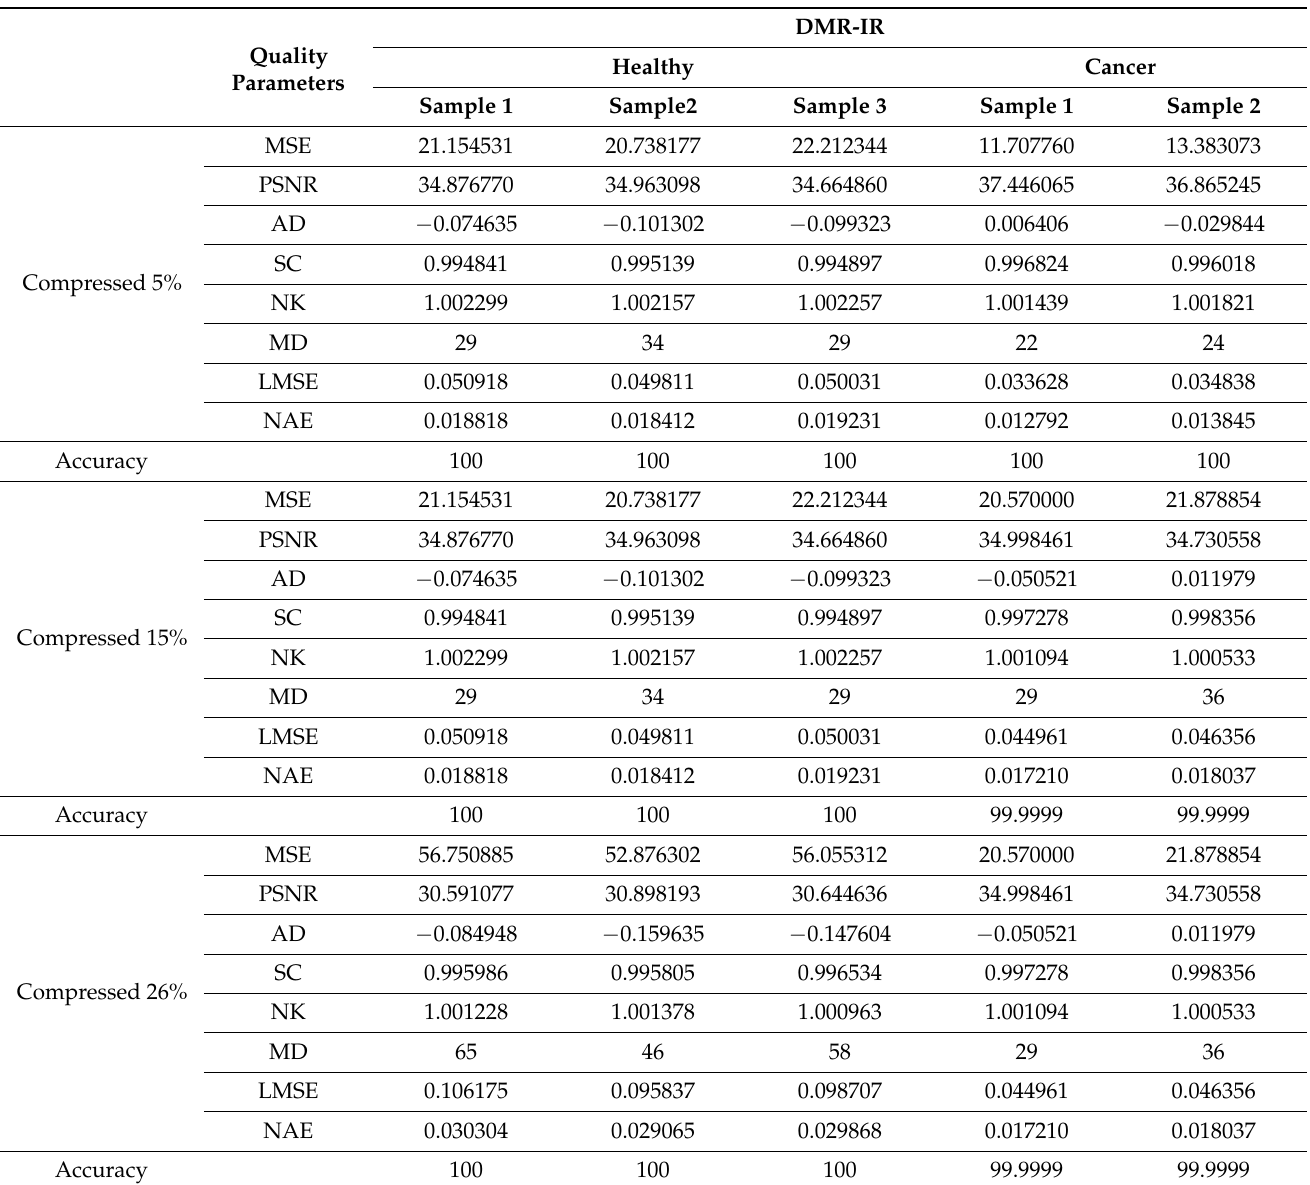
Table 4. Compressed DMRIR image and check